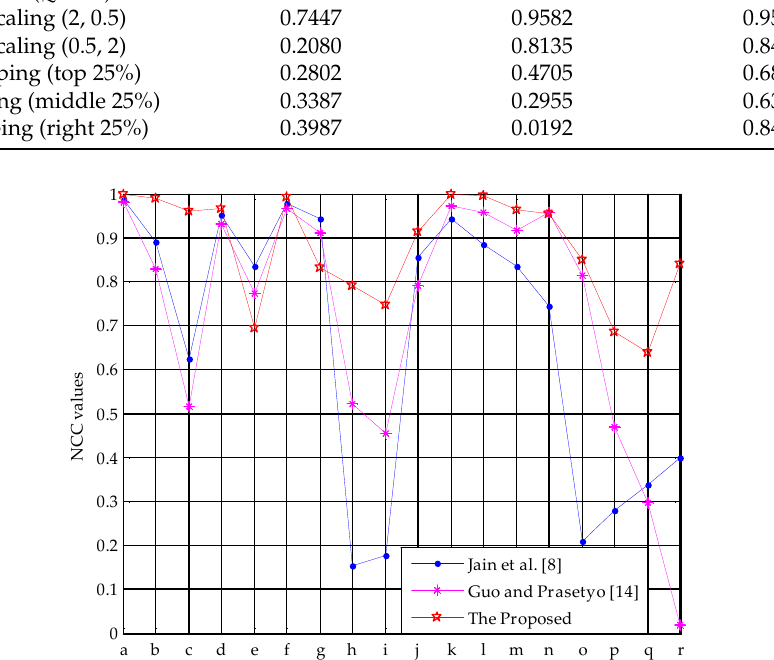
Figure 8. Robustness comparisons for host image Barbara: ( a ) No attack; ( b ) Salt and pepper noise (0.001); ( c ) Salt and pepper noise (0.005); ( d ) Gaussian noise (0, 0.0001); ( e ) Gaussian noise (0, 0.0005); ( f ) Speckle noise (0.0001); ( g ) Speckle noise (0.0005); ( h ) Median filter (3 × 3); ( i ) Average filter (3 × 3); ( j ) Image sharpening; ( k ) JPEG ( Q = 90); ( l ) JPEG ( Q = 80); ( m ) JPEG ( Q = 70); ( n ) Rescaling (2, 0.5); ( o ) Rescaling (0.5, 2); ( p ) Cropping (top 25%); ( q ) Cropping (middle 25%); ( r ) Cropping (right 25%).